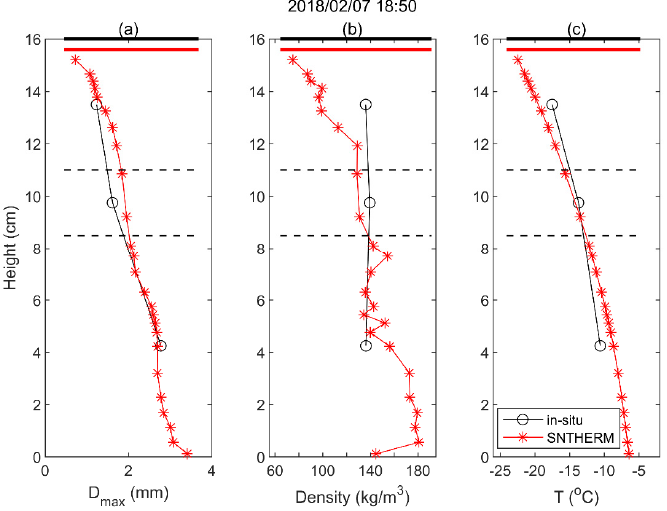
Figure 4. Comparison of the vertical profiles of snow parameters on February 7, 2018 between the SNTHERM simulation and Altay in situ measurements: ( a ) geometric grain size (D max ); ( b ) snow density; and ( c ) physical temperature (T). Table 1. Statistics for the multiple-layer snow properties of the Altay snow samples.